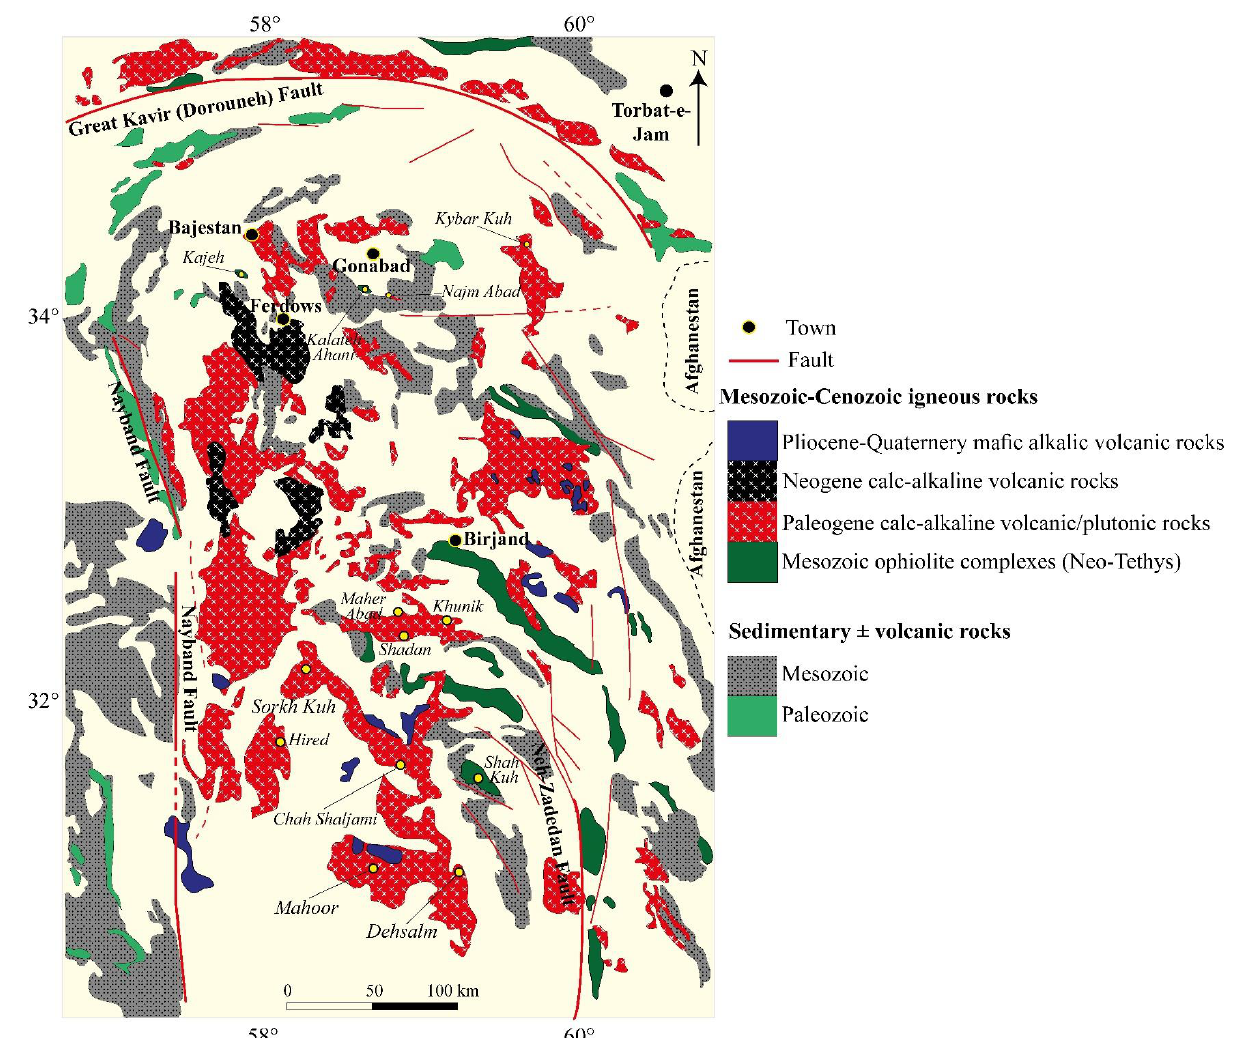
Figure 2. Geology of the Lut Block, eastern Iran, modified from [24].